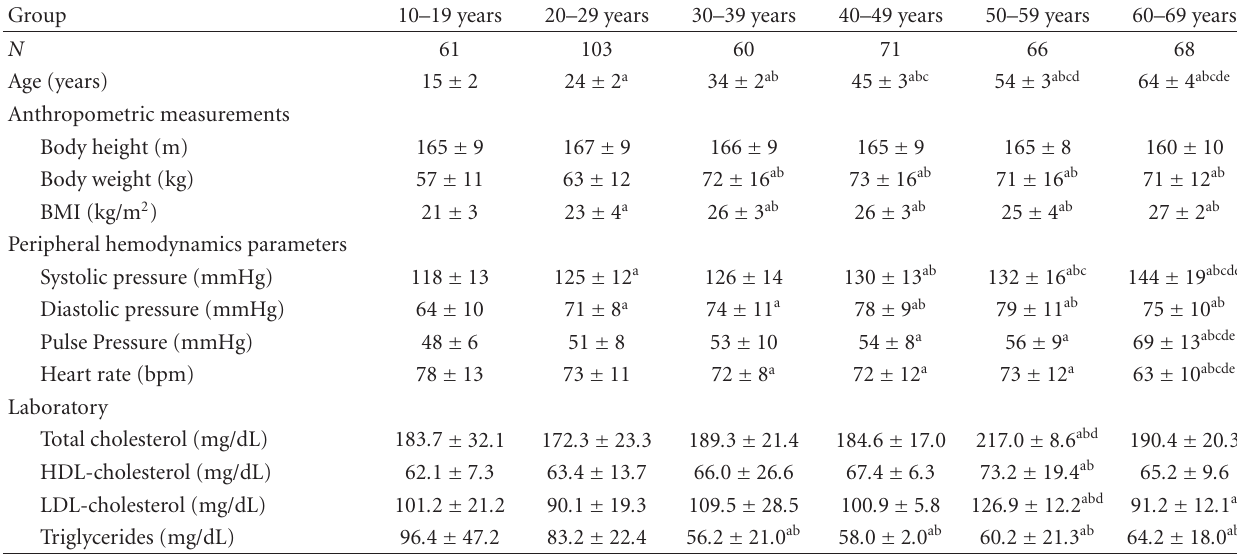
Table 1: Clinical and hemodynamic